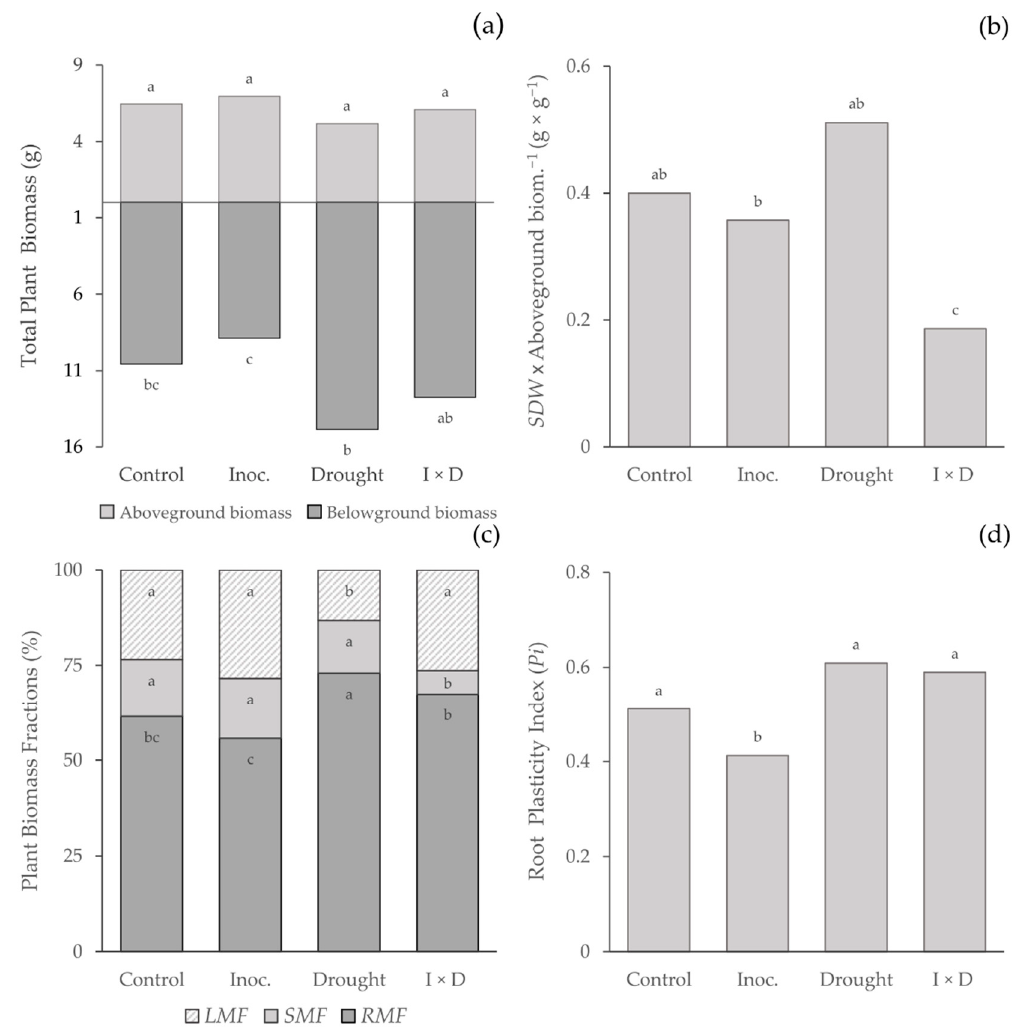
Figure 4. Plant biomass analysis ( a ) Biomass distribution per treatment. Upside mean aboveground (Stem and leaves) biomass. Downside mean belowground (root) biomass. ( b ) Relative stem biomass with respect to total aboveground biomass, per treatment. ( c ) Plant fractions for each treatment. LMF = Leaf mass fraction. SMF = Stem mass fraction. RMF = Root mass fraction. ( d ) Average plasticity index for each treatment. Error bars show ± SE. Bars with the same letter are not significantly different ( p >